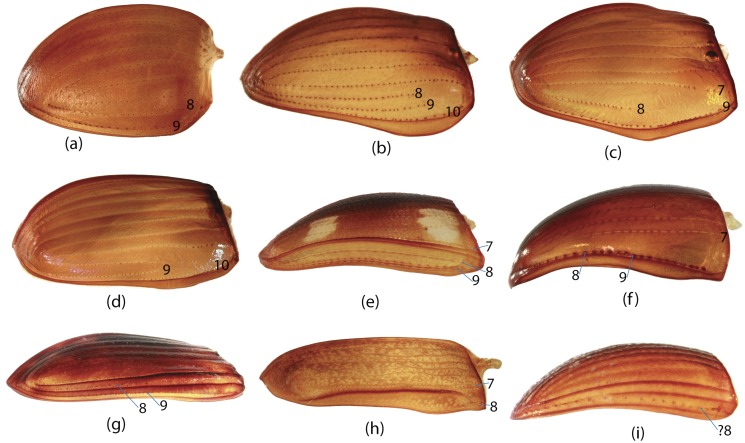
Elytra of Scarabaeinae.a, Eucranium arachnoides; b, Ennearabdus lobocephalus; c, Gromphas aeruginosa; d, Oruscatus davus; e, Ochicanthon sp.; f, Arachnodes sp.; g, Scarabaeus sp.; h, Eurysternus hamaticollis; i, Tanzanolus sp.; a-i, right elytron, lateral view. Elytral striae are enumerated; indistinct striae or their traces are marked by *.